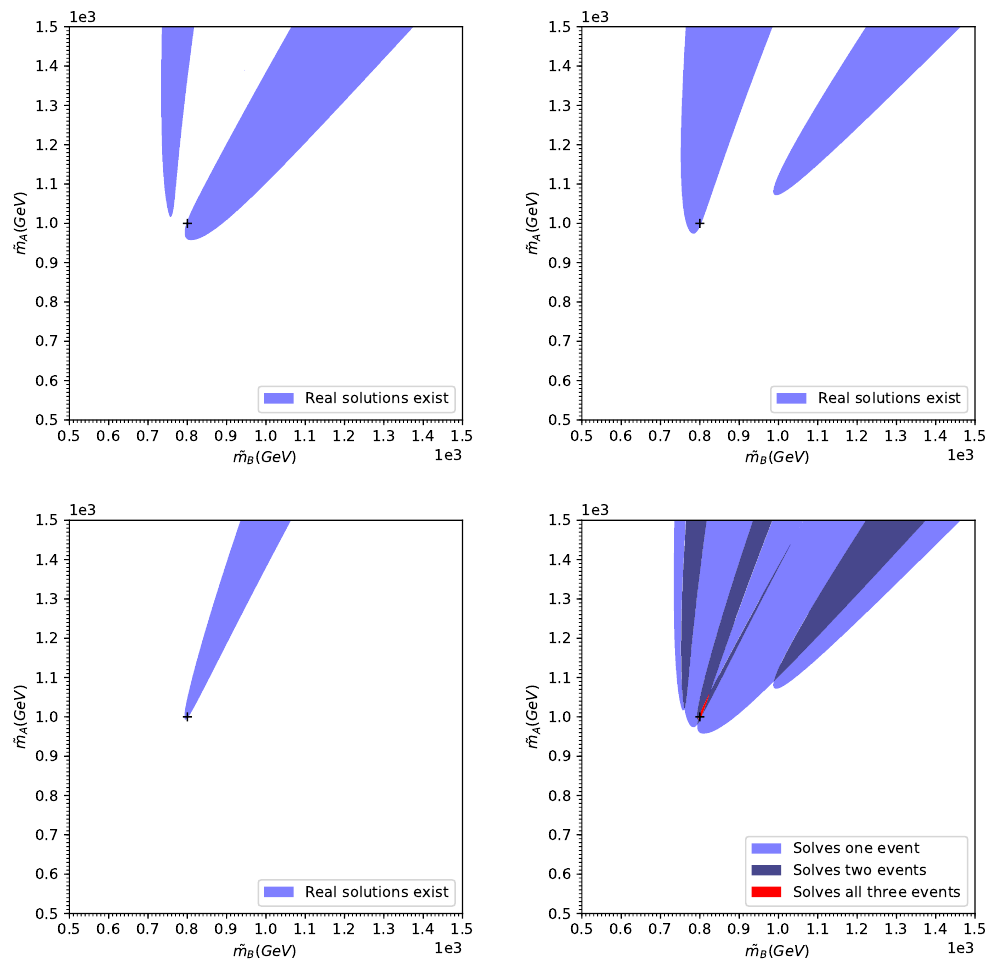
Figure 6 . The same as (cid:12)gure 5, only now we superimpose the allowed regions for three suitably chosen events (shown in the top left, top right and bottom left panels). The cross marks the true mass point ( m ; m ). The three events were selected to be complementary to each other in the B A sense that when taken together they would rule out a large portion of the parameter space. In the bottom right panel white areas are incompatible with all three events, blue light-shaded areas solve one event but not the other two, blue dark-shaded areas solve two events, but not the third, while the narrow red-shaded sliver extending away from the cross solves all three